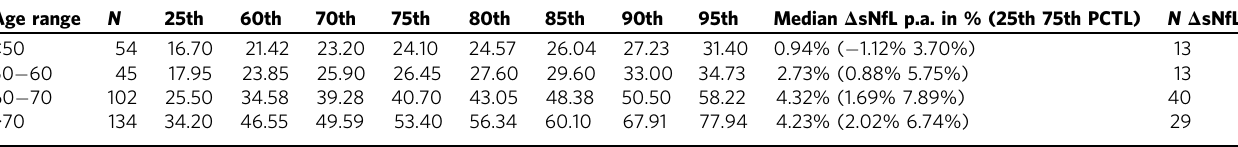
Table 3 Percentiles and annual increase of sNfL in each age group.